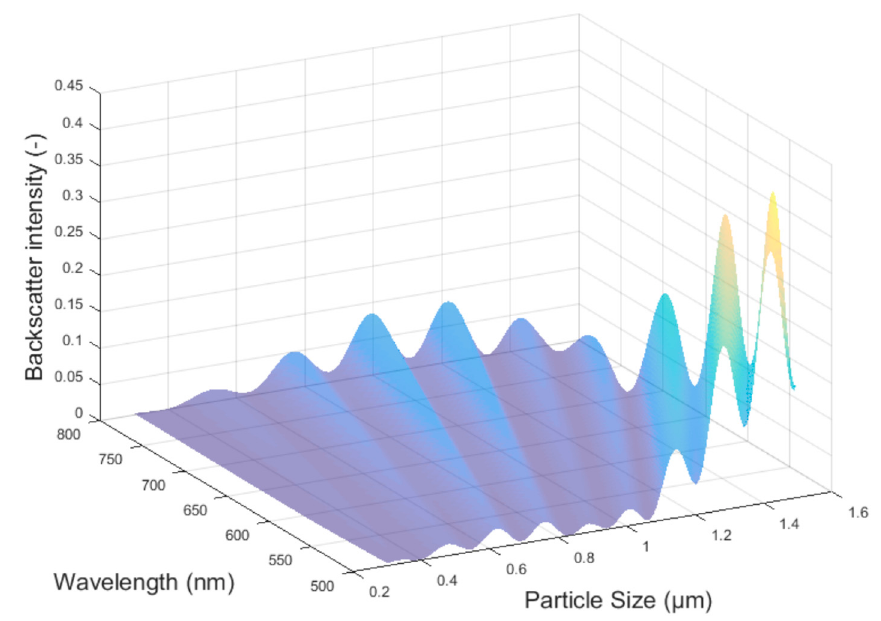
Figure 2. Mie back scattering intensity at 180° vs. particle size and wavelength [7].